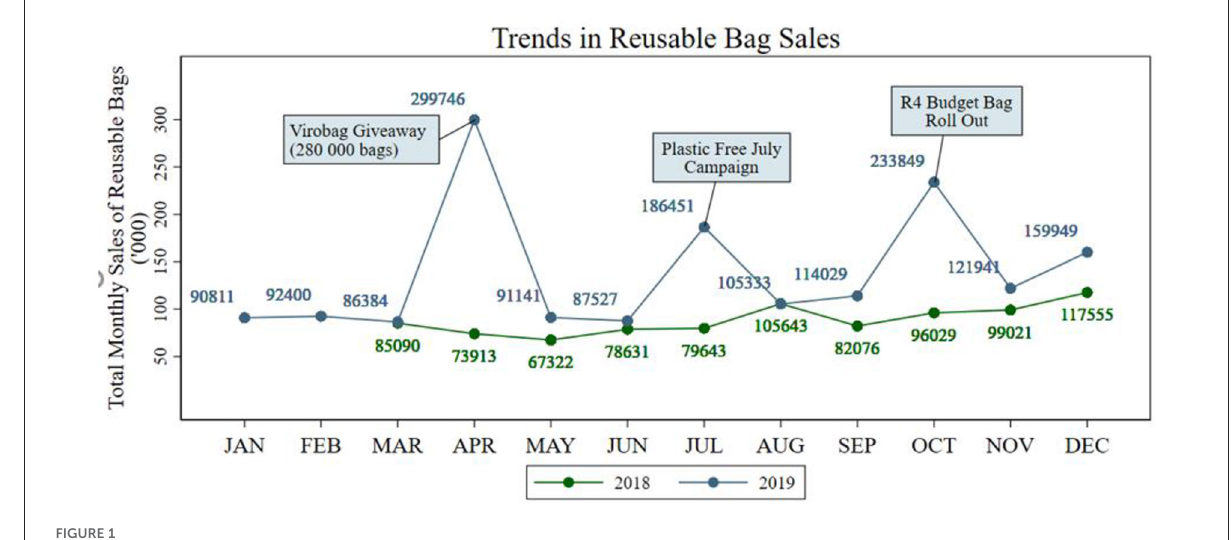
FIGURE1 Trends in reusable bag sales during 2018 and 2019.